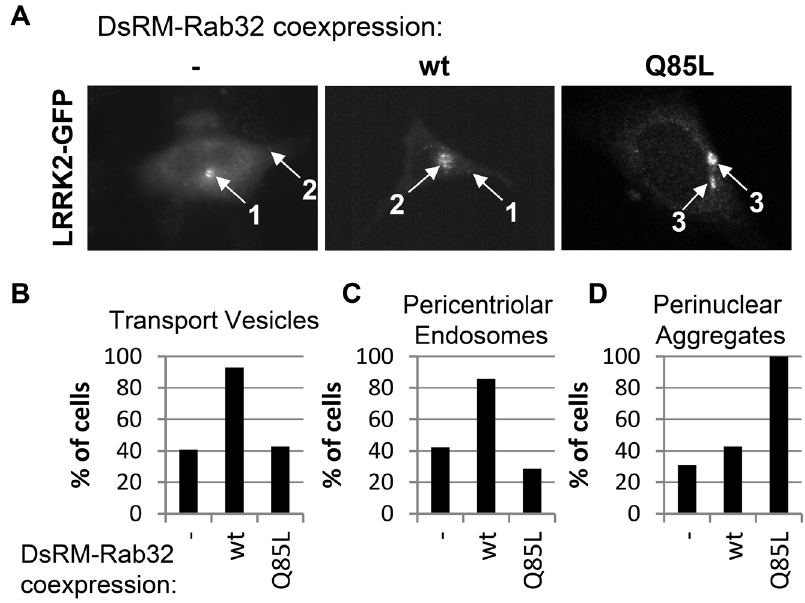
Figure 5. LRRK2-GFP subcellular localization in DsRed-Monomer-Rab32 wt and DsRed-Monomer-Rab32 Q85L overexpressing NIH3T3 cells. (A) Graphical representation of the most common subcellular features of LRRK2-GFP in DsRed-Monomer-Rab32 wt or DsRed- Monomer-Rab32 Q85L expressing cells. 1: pericentriolar endosome; 2: transport vesicles; 3: perinuclear aggregates. (B–D) Microscopic analysis of NIH3T3 cells co-transfected with plasmids encoding DsRed-Monomer-Rab32 wt or DsRed-Monomer-Rab32 Q85L and LRRK2-GFP. In every cell the LRRK2-GFP channel was analyzed for the occurrence of the features transport vesicles, pericentriolar endosomes and perinuclear aggregates. (-) LRRK2-GFP alone: n=71 cells from 5 independent experiments; LRRK2-GFP and DsRed-Monomer-Rab32 wildtype: n=15 cells from 3 independent experiments, LRRK2-GFP and DsRed-Monomer-Rab32 Q85L: n=21 cells from 5 independent experiments.